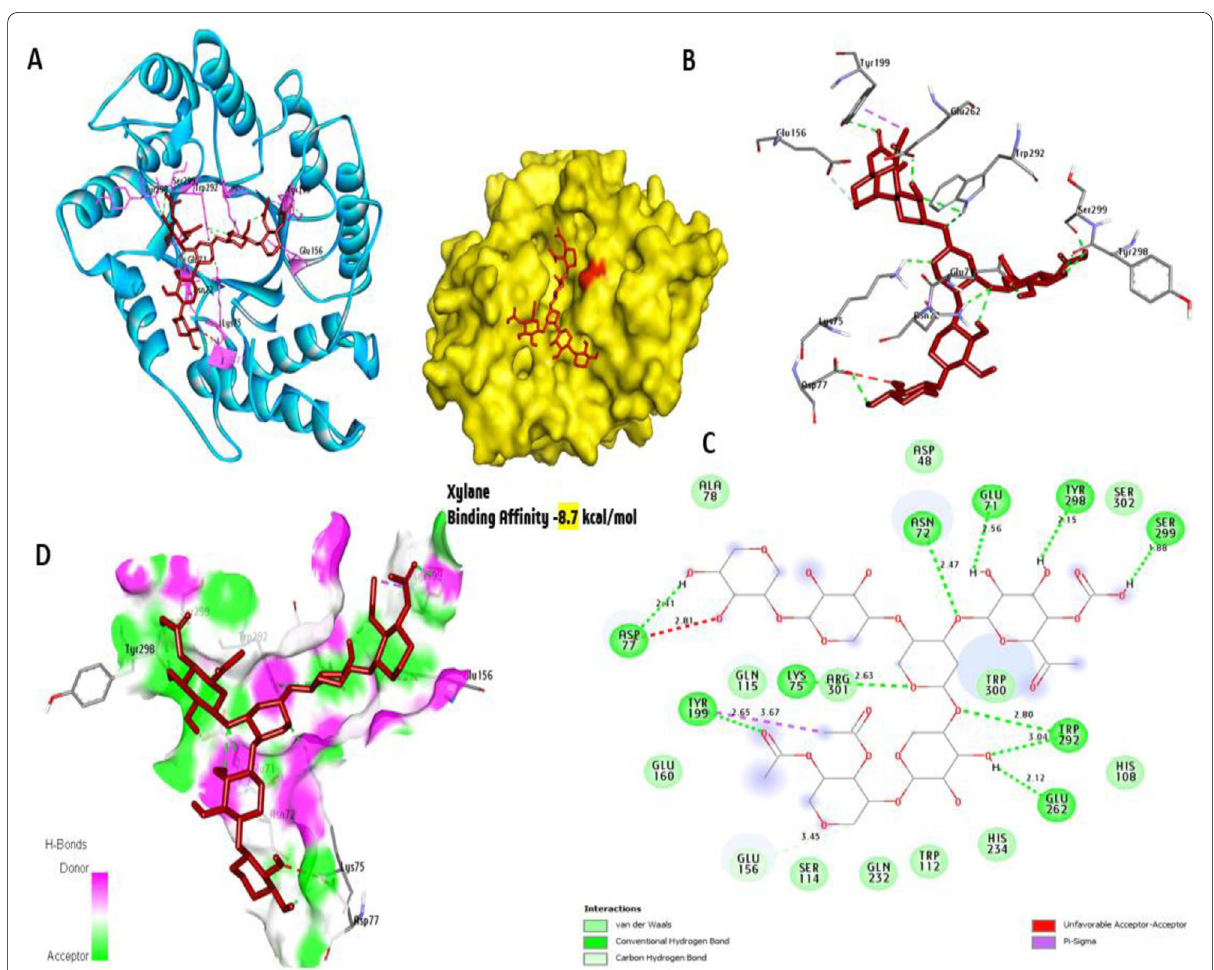
Fig. 24 Molecular interactions of xylan with amino acids of the 3D model of xylanase with the best binding mode in the pocket of protein (with ligand as color sticks). A Complex interaction with sticks red color, B 3D interaction amino acid residues involved in the interaction (with ligand as color sticks), C 2D interaction binding interaction of ligands with an amino acid with hydrogen bond (green dash line), and D display receptor surface with H‑bond donor and